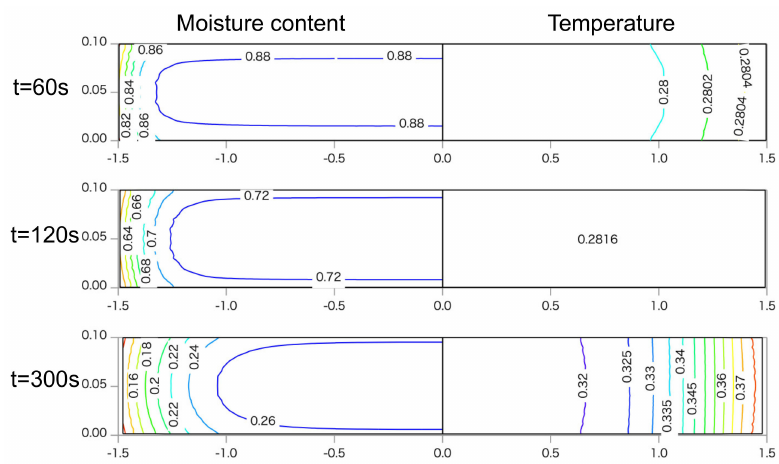
Figure 7. Profiles of moisture, temperature, and deformation behavior during both sides drying (hot air temperature 100 ◦ C).